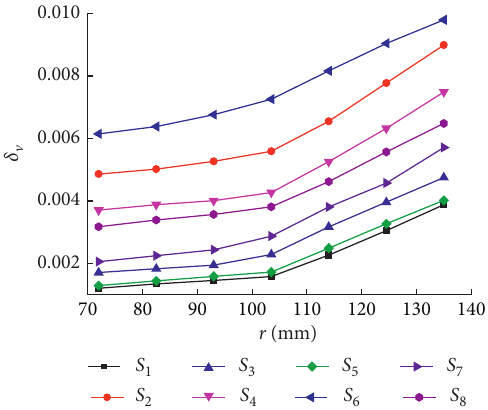
Figure 8: Coefficient of uneven tangential velocity distributed along radial